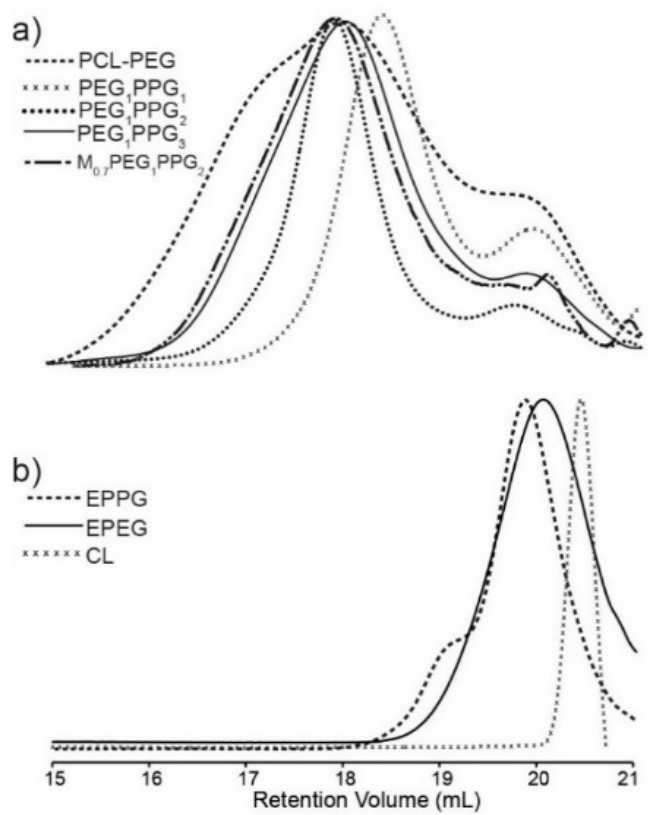
Figure 2. GPC differential refractive index (DRI) chromatograms of ( a ) PCL–PEG and PEG x PPG y Figure 2. GPC di ff erential refractive index (DRI) chromatograms of ( a ) PCL–PEG and PEG x PPG y copolymers and ( b ) EPPG, EPEG and CL macromonomers. copolymers and ( b ) EPPG, EPEG and CL